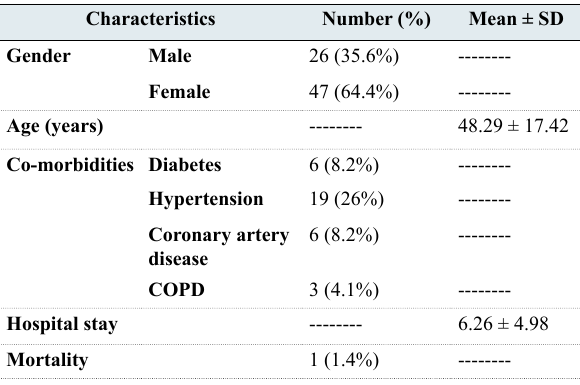
Table 1: Characteristics of the patients included in the study Characteristics